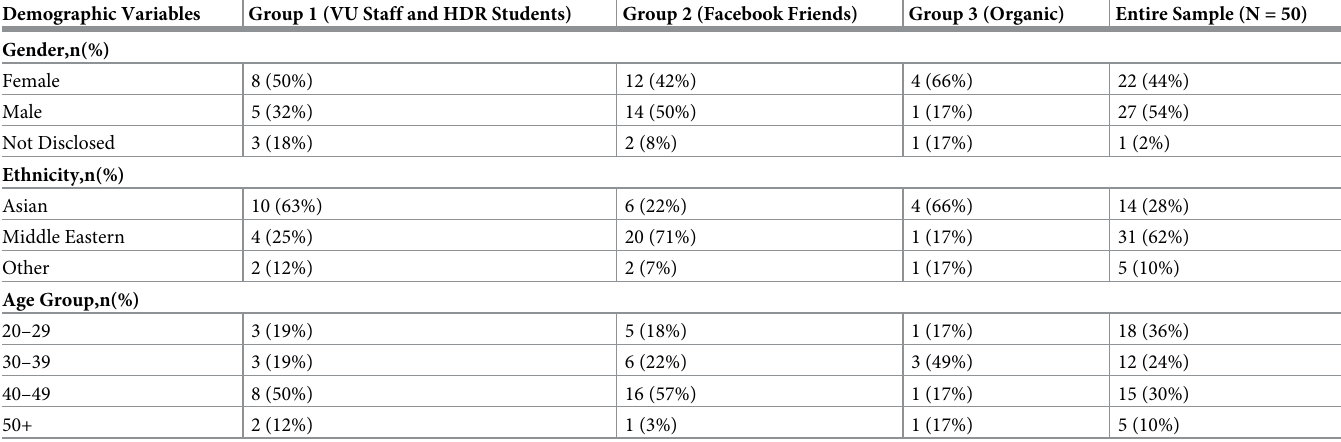
Table 4. Demographic variables of